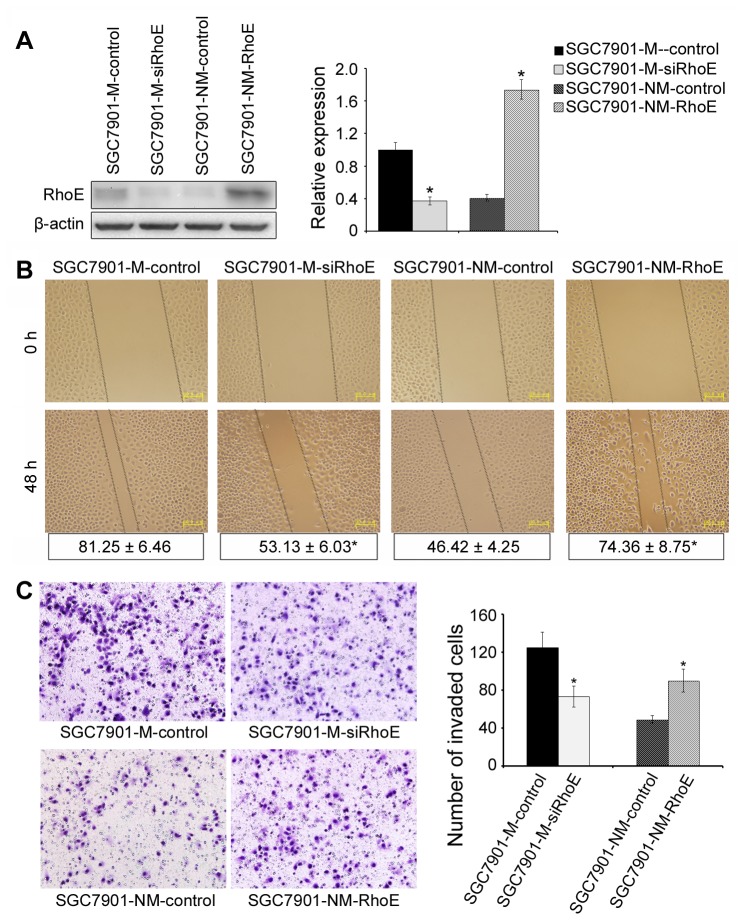
RhoE promotes the migratory and invasive abilities of gastric cancer cells in
vitro.(A), RhoE was down-regulated in SGC7901-M cells after treatment with siRNA while RhoE expression was up-regulated in SGC7901-NM cells after treatment with lentivirus. RhoE protein levels were confirmed by Western blot analysis. (B), The migratory ability of the cells was evaluated by a wound-healing assay. The wound widths of each sample were measured at different time-points by phase-contrast microscopy (Olympus, Tokyo, Japan), and the closure ratio was calculated in accord with the following formula: Wound Closure (%) = (width 0 h) - width 24 h) / width 0 h. *P <0.05. These results were then compared to those of the control cells. (C), Tumor cell invasion activities were measured by transwell assay. Representative image fields of invasive cells on the membrane are shown. Data are represented as normalized cellular invasion (invasion index) relative to control cells. *P <0.05. The images shown are representative of three experiments.